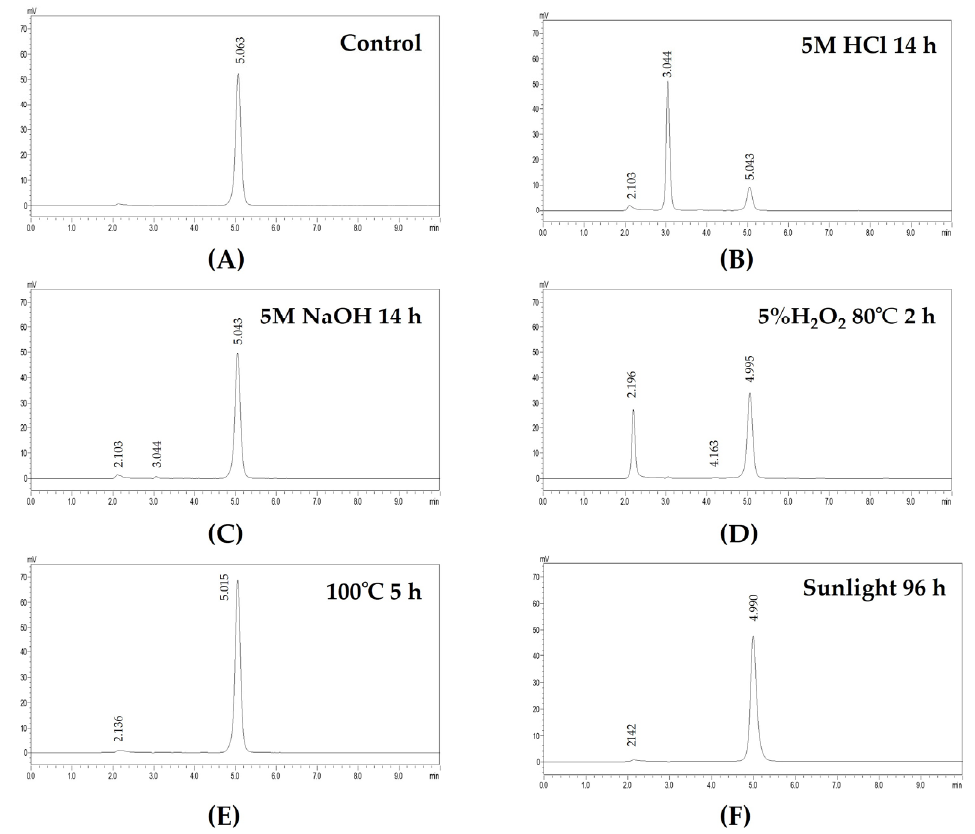
Figure 2. HPLC chromatograms of ganciclovir after being subjected to the stress conditions. ( A ) Control; ( B ) acid hydrolysis; ( C ) base hydrolysis; ( D ) oxidation; ( E ) heat degradation; and ( F ) pho- tolytic decomposition.